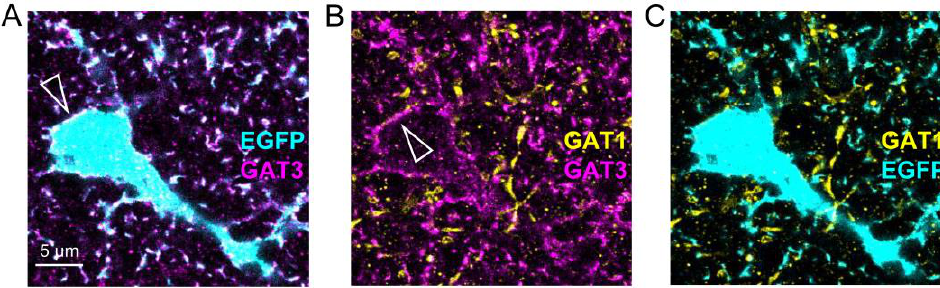
Figure 5. Colocalization of GABA transporters 3 (GAT3) but not 1 (GAT1) with astrocytes. Example of an expansion microscopy experiment of an astrocyte expressing EGFP (cyan) with GAT1 (yellow) and GAT3 (magenta). ( A ) Colocalization of EGFP and GAT3. Note the GAT3 label at the astrocyte cell surface (e.g., at the cell body, white triangle). ( B ) Lack of colocalization between GAT1 (yellow) and GAT3 (magenta). Note how GAT3 outlines the astrocyte surface (white triangle). ( C ) Lack of colocalization between astrocytic EGFP (cyan) and GAT1 (yellow). Scale bar in ( A ) applies to all panels.